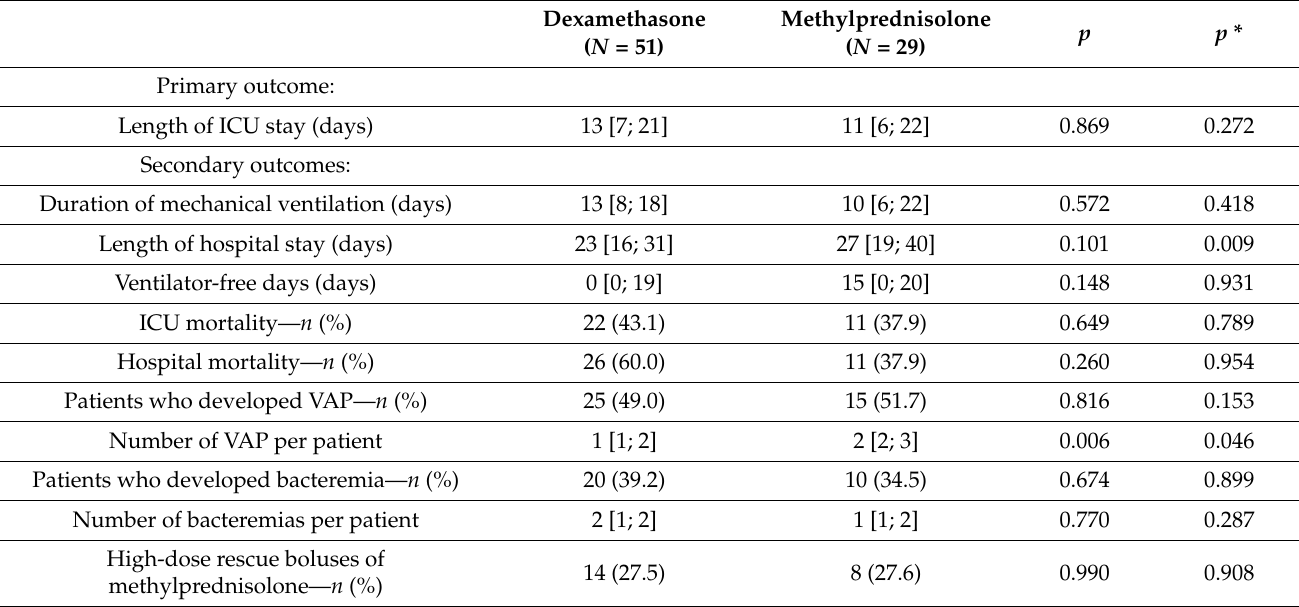
Table 2. Comparison of the outcomes of patients who received dexamethasone vs. methylprednisolone. Dexamethasone